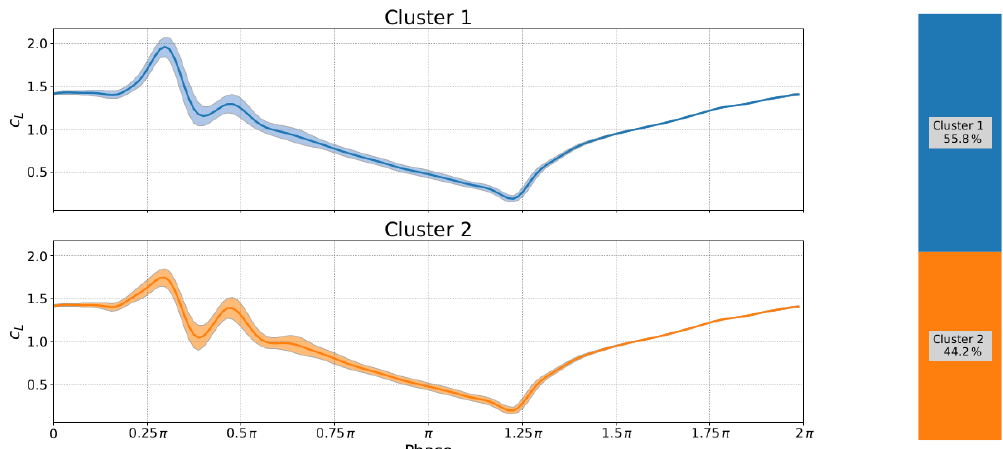
Figure 17. Deep stall investigations: cluster analysis for boundary conditions: k = 0 . 0992, Re = 3 × 10 5 and α 0 = 18 ◦ , α amp = 7 ◦ .